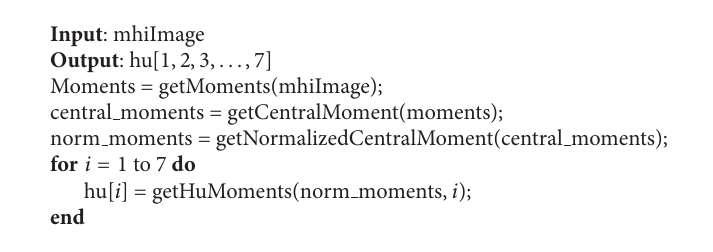
Algorithm 2: Feature generation from MHI using Hu moments.